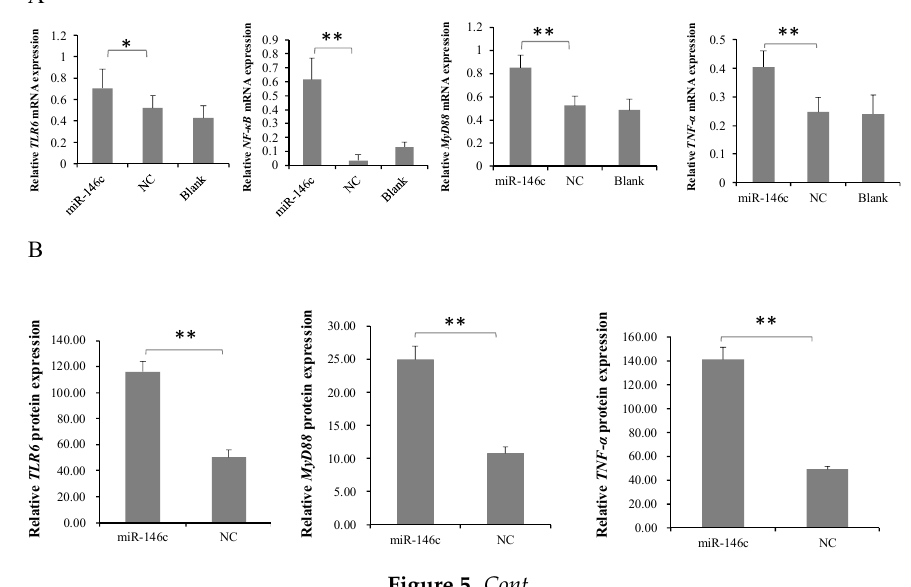
NF- κ B signaling pathway in inflammation response.